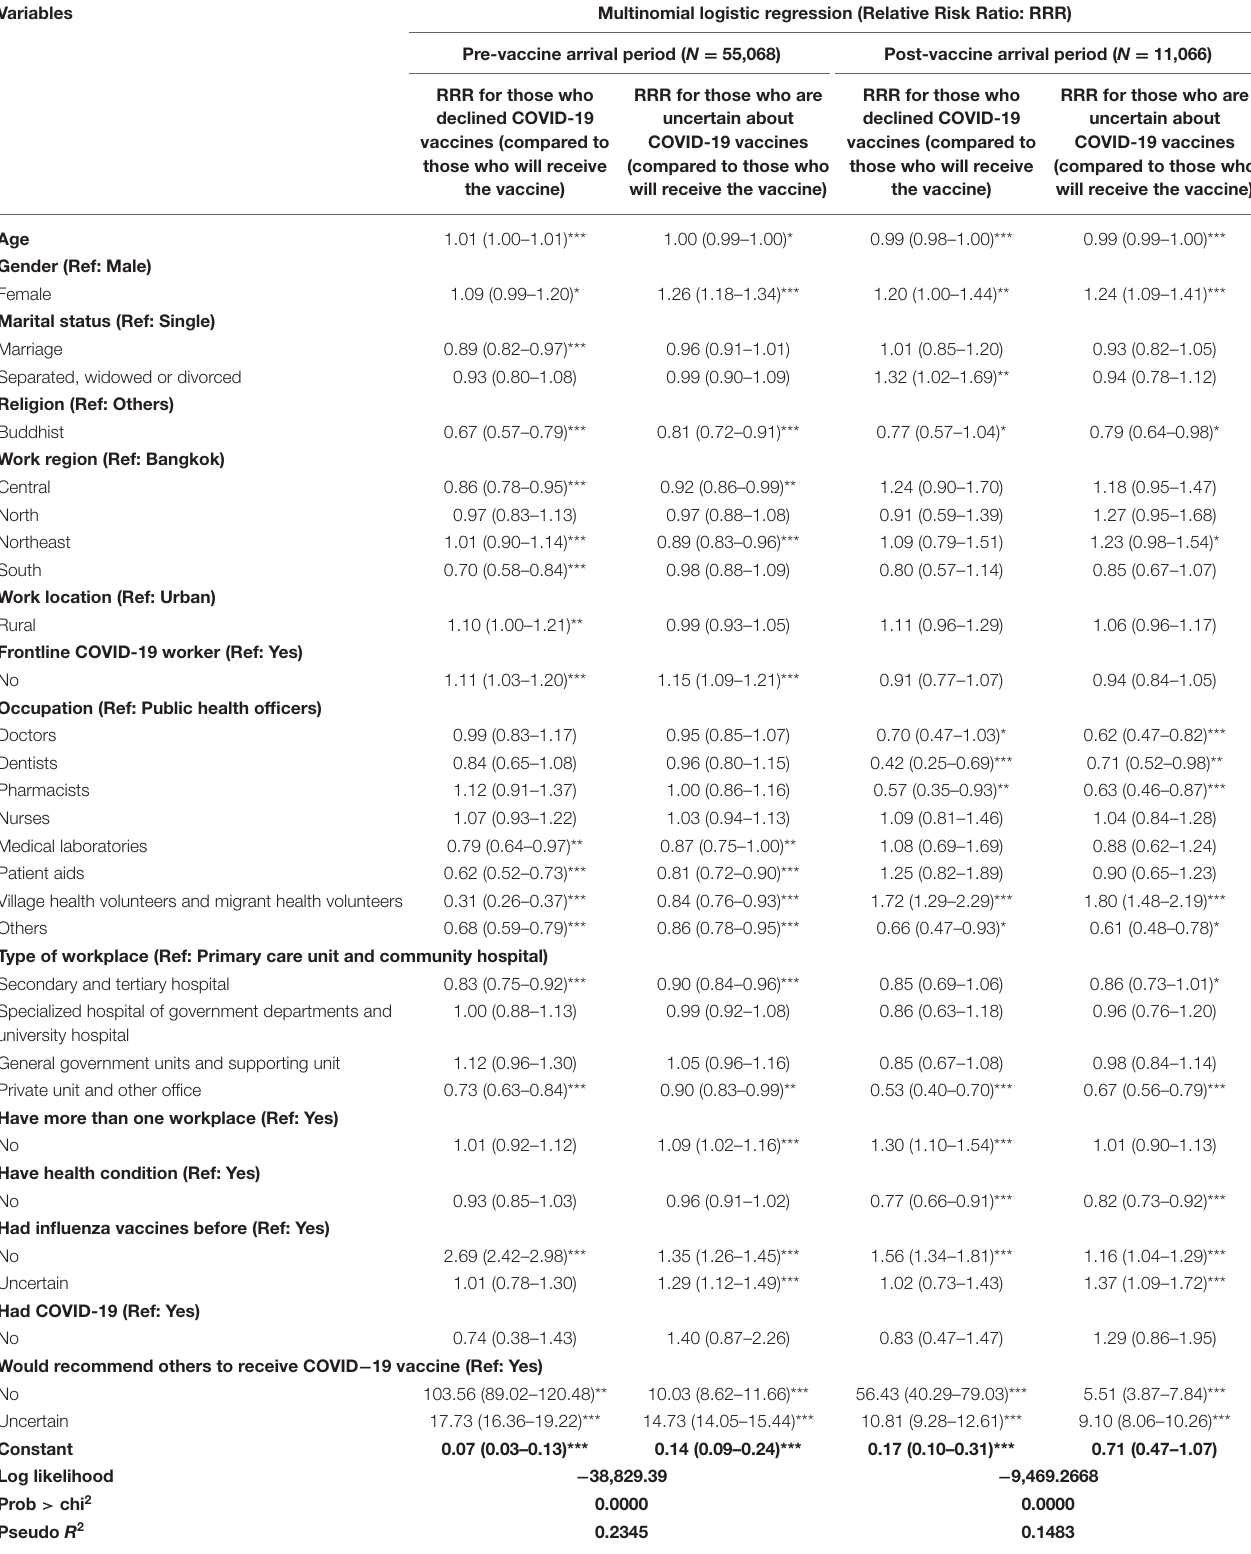
TABLE 4 | Factors associated with COVID-19 vaccine hesitancy among participants who have not received vaccination between in the pre- and post-vaccine period. Variables Multinomial logistic regression (Relative Risk Ratio: RRR)